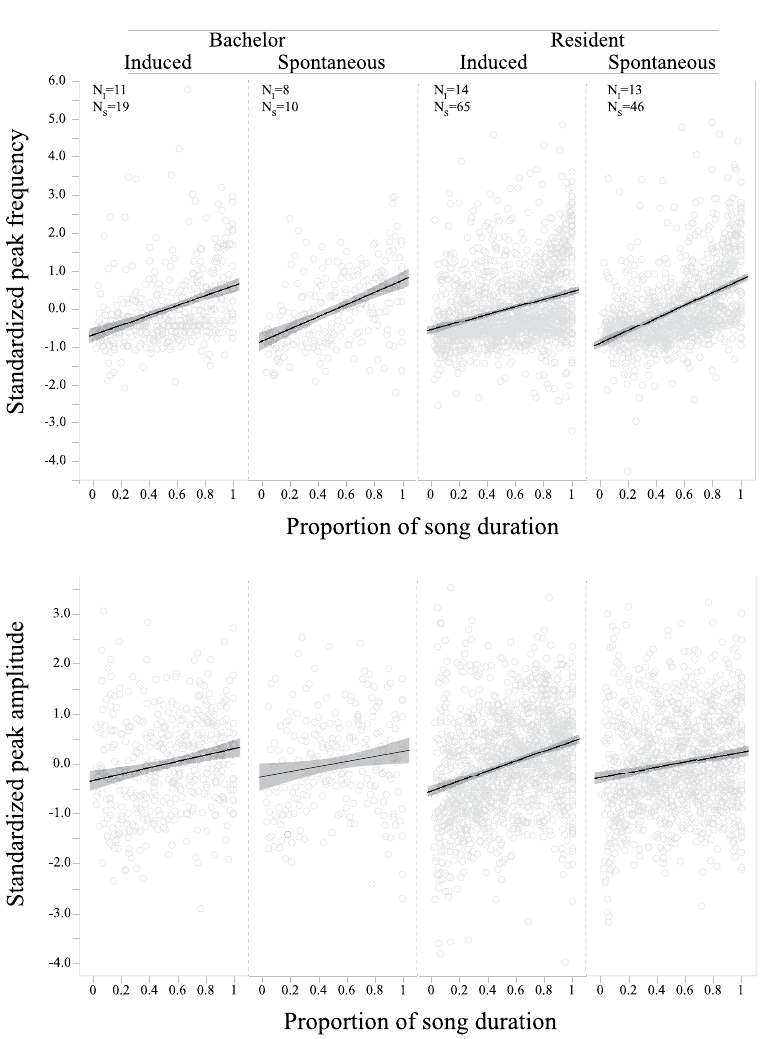
Figure 2. Progression plots of ( a ) standardised peak frequency and ( b ) standardised peak amplitude of vocal element and their proportional location through the signal. The trend lines show linear slope estimates with CI as shaded areas. Bachelor songs were performed by males without stable association with a female group. Resident songs were performed by males that were regularly observed associating with a female group. Induced songs were performed following an external trigger event. Spontaneous songs were performed without any observable trigger. N i denotes number of individual males and N s denotes number of songs in a corresponding